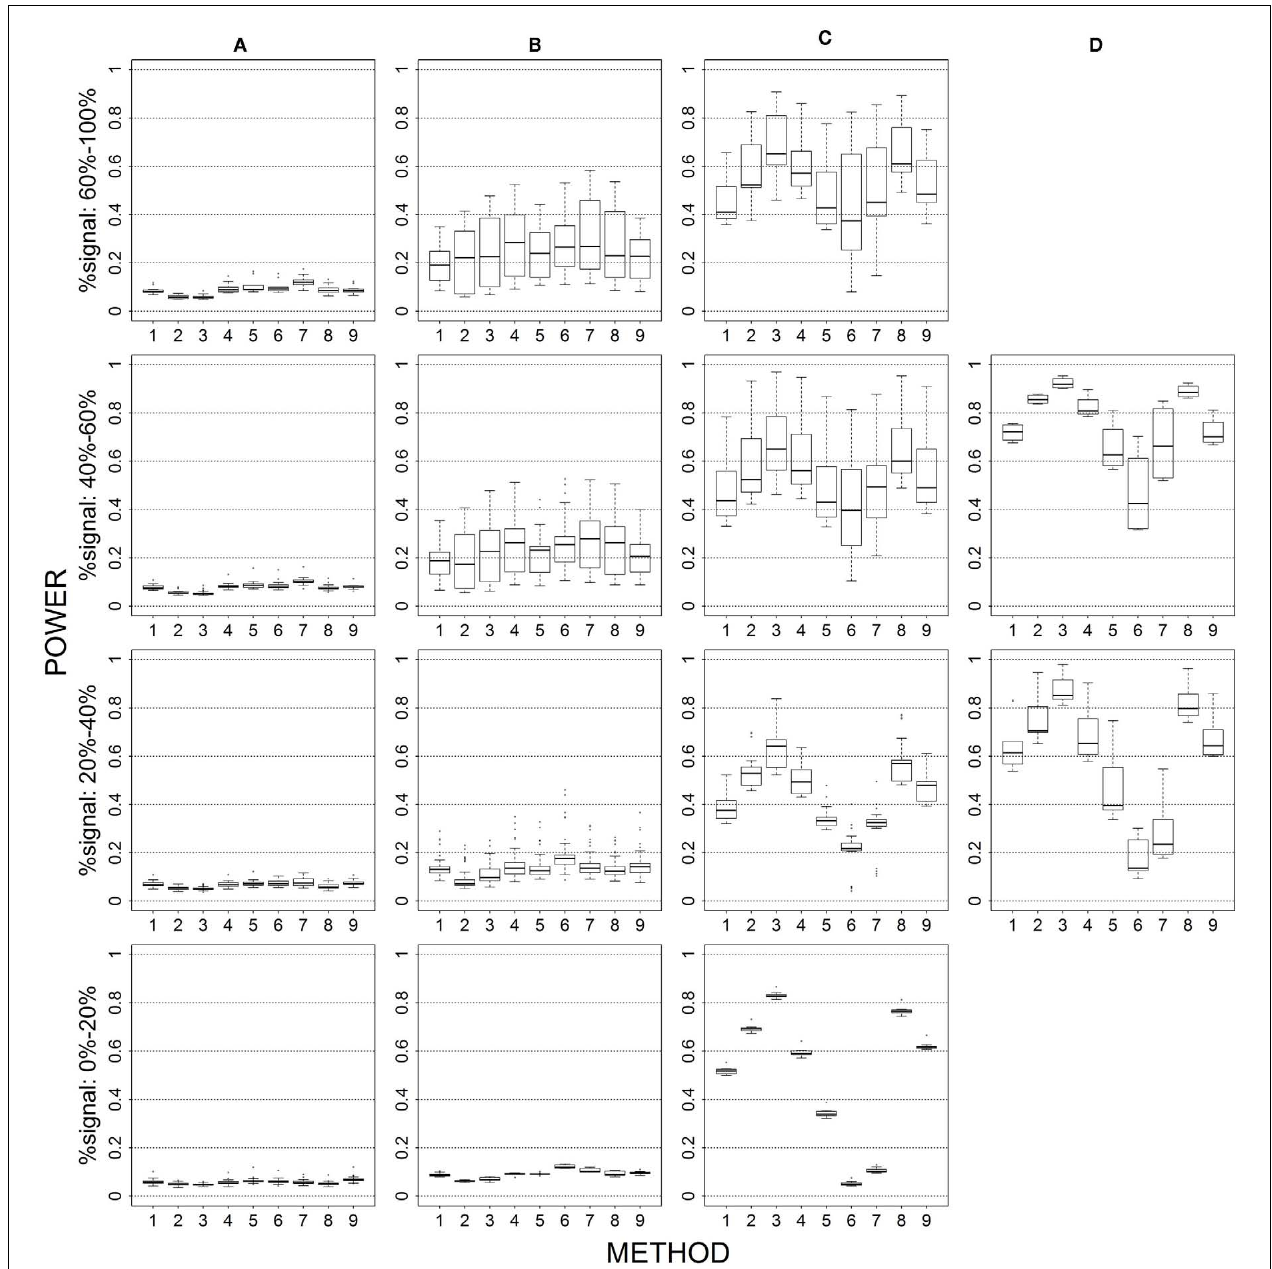
marker-combinations belonging to each average functional allele frequency [ (A) is 0–0.01, (B) is 0.01–0.05, (C) is 0.05–0.10, (D) is 0.10–0.20]